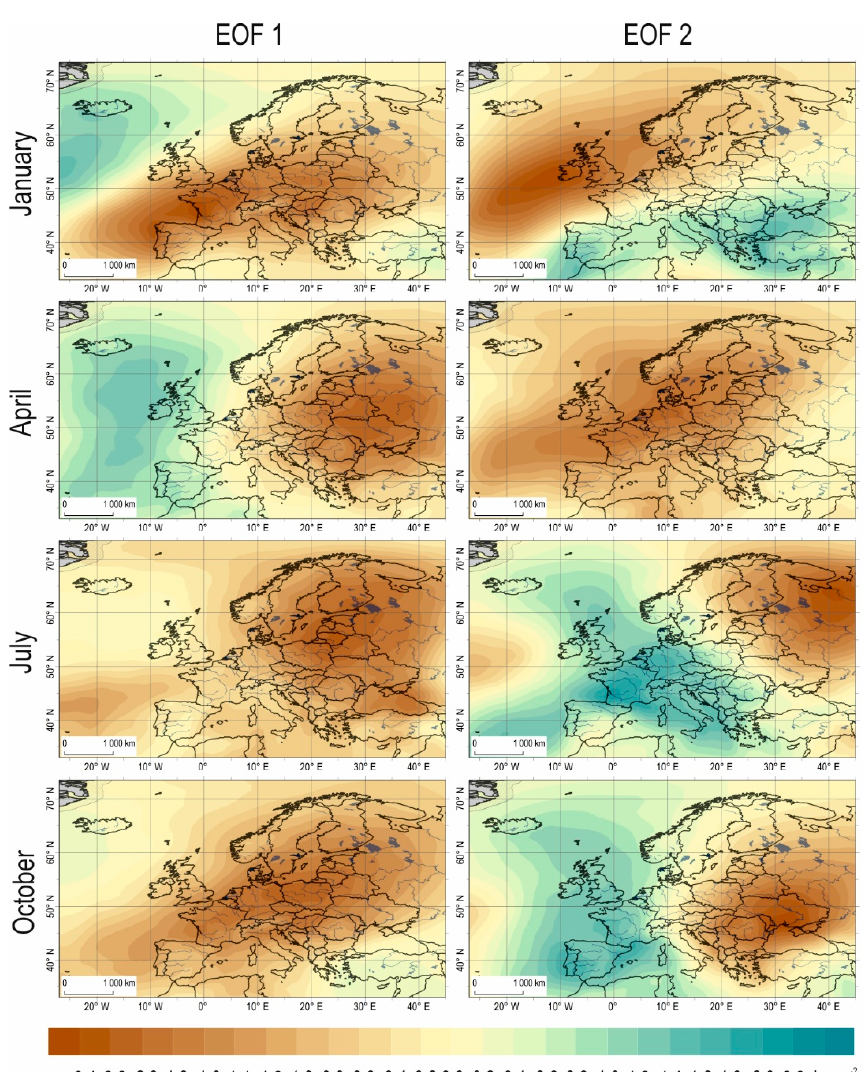
Figure 4. Spatial patterns of TCWV anomalies (kg·m − 2 ) in selected months for two leading EOF modes (1981–2015).